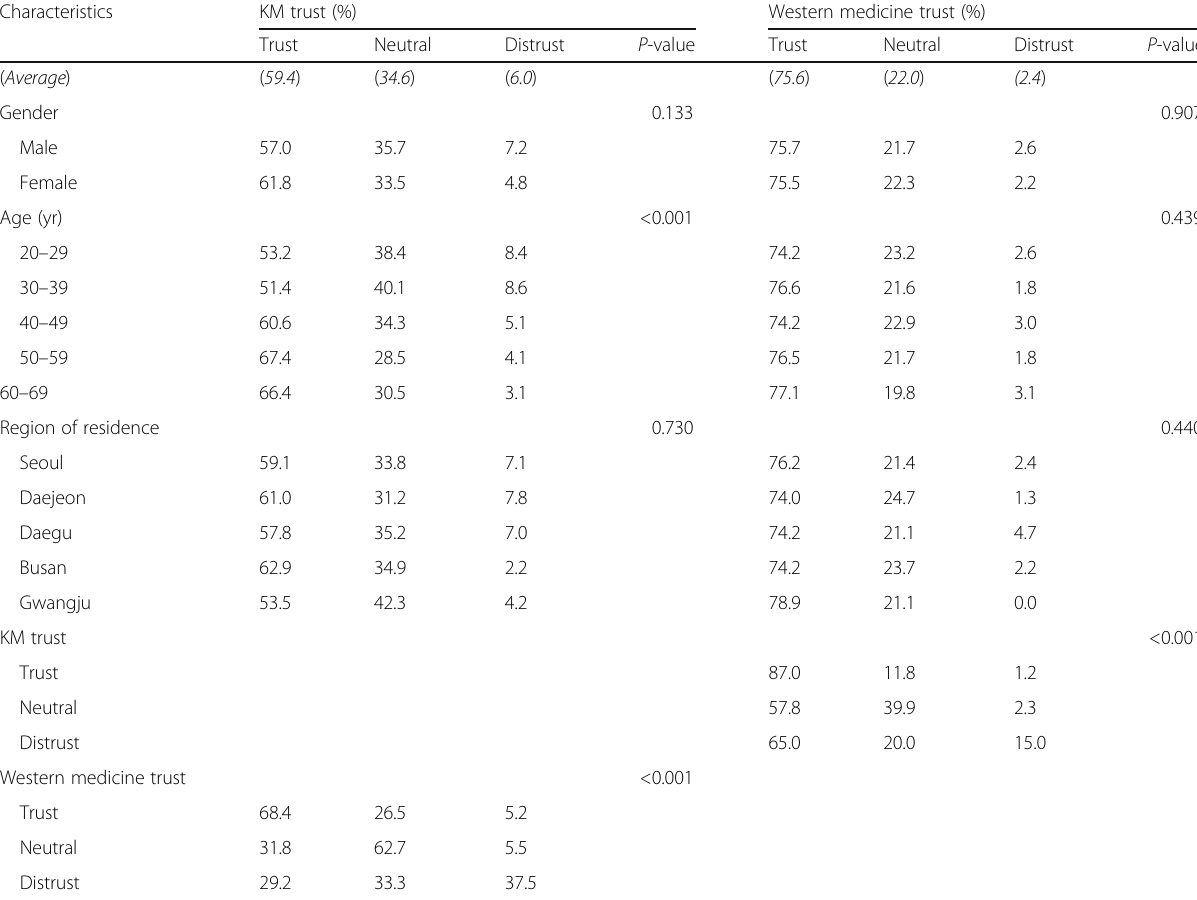
Table 2 Trust in KM and Western medicine in 2014